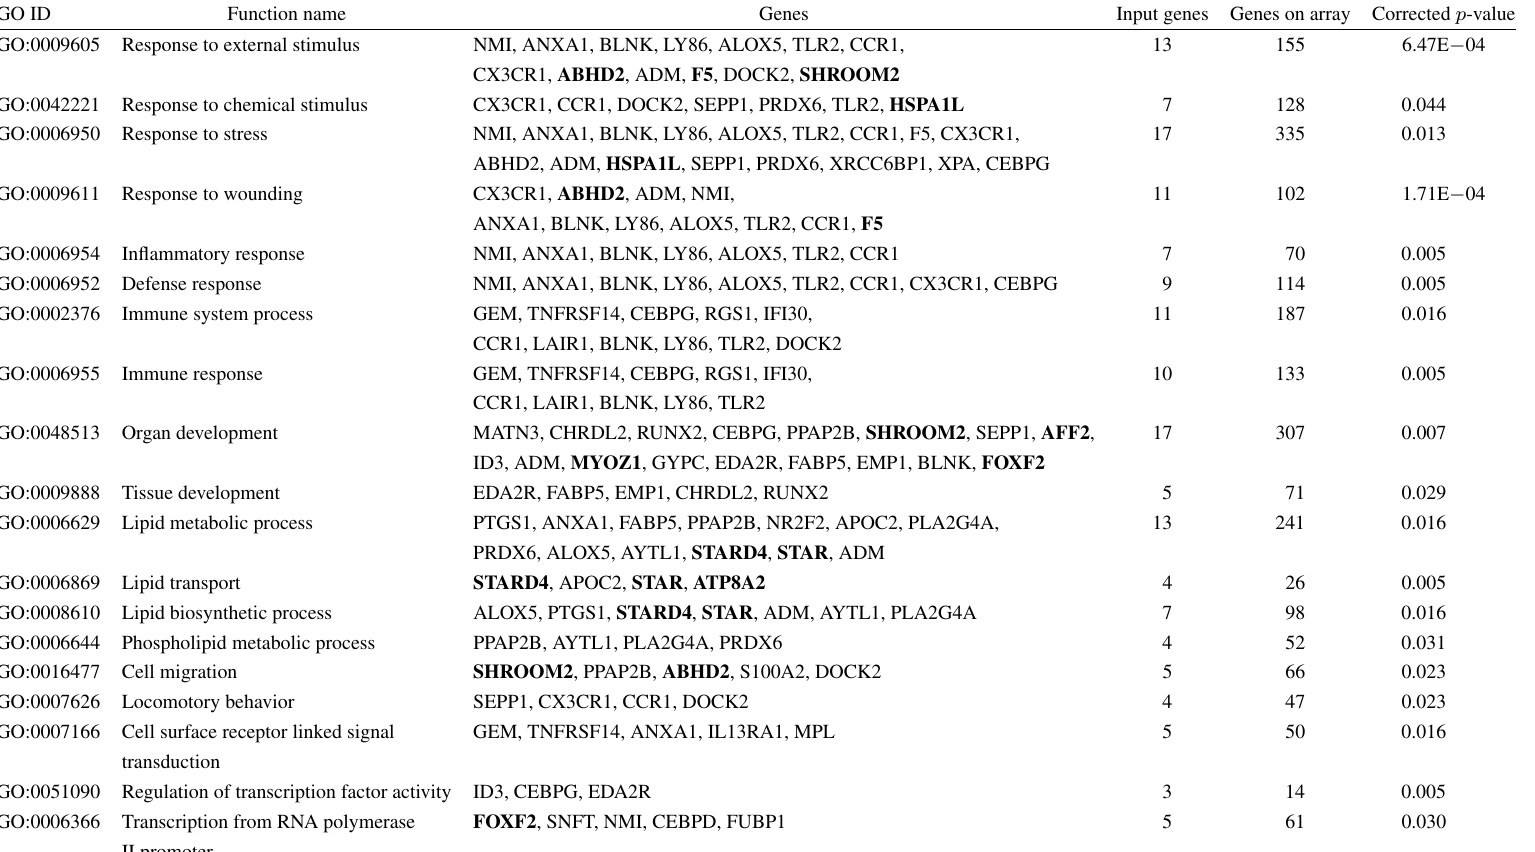
Biological processes containing genes differentially expressed between those tumors with 1p / 19q loss and those